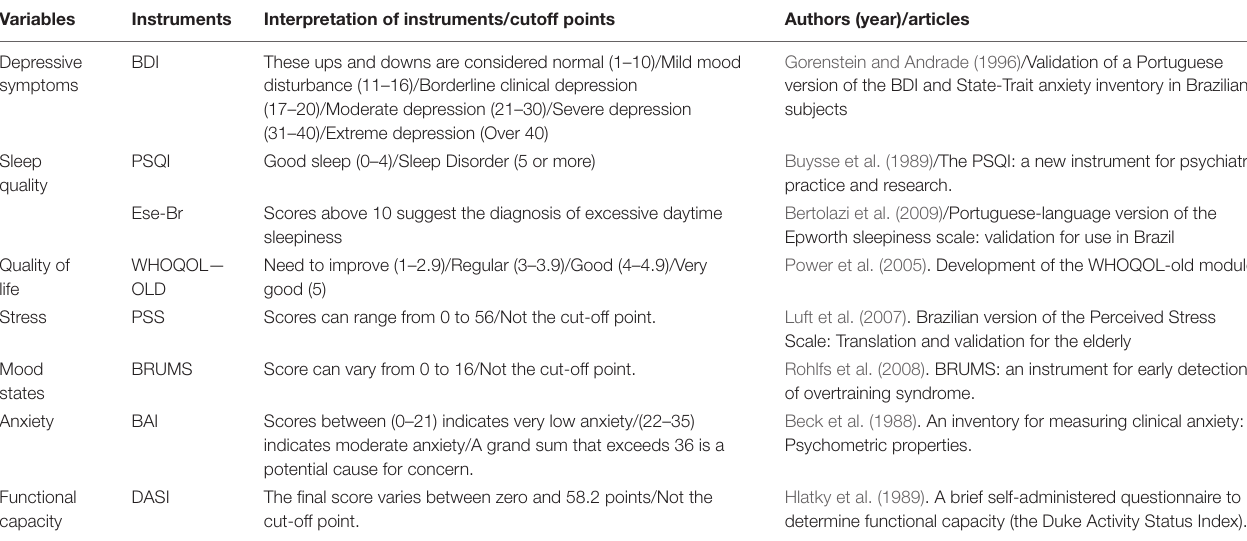
TABLE 1 | List of variables, instruments used, interpretation and